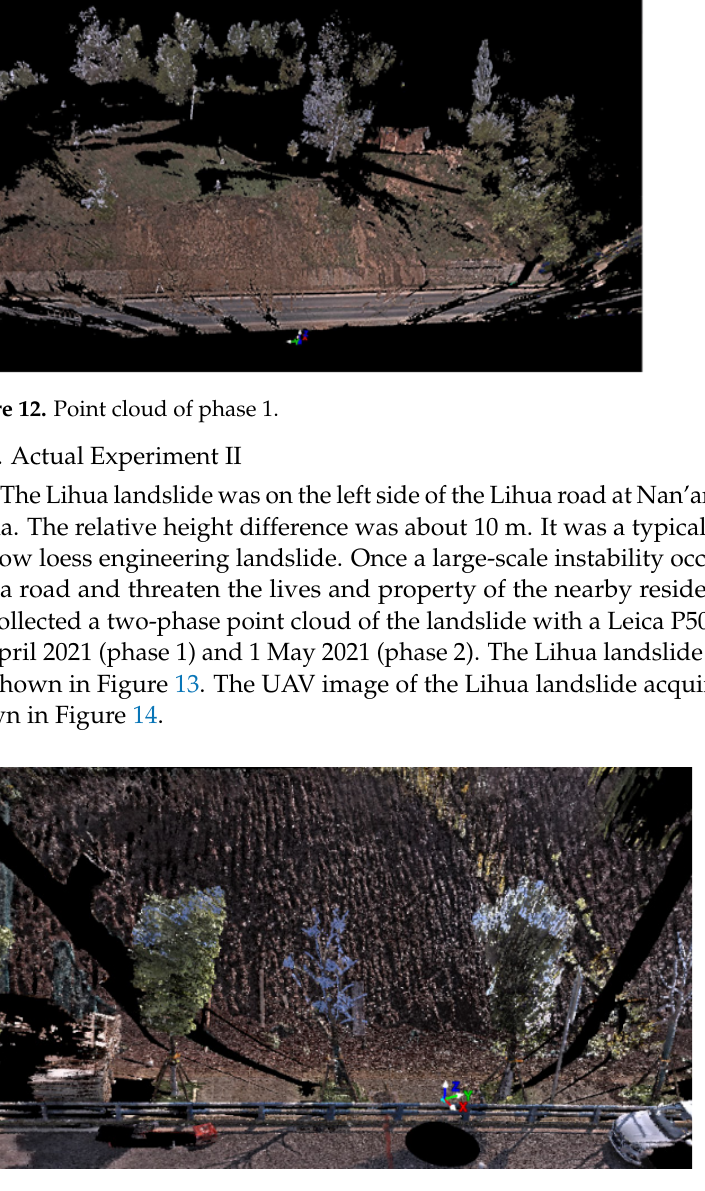
Figure 14. UAV image of Lihua landslide. 4. Analysis of Result and Discussion 4.1. The Results of Simulation Experiments 4.1.1. The Result of Simulation Experiment I In simulation experiment 1, the square root of unit weight variance is 0.3. The param- eter values obtained using the three methods are shown in Table 5. Table 5. Parameter estimation and accuracy. Method